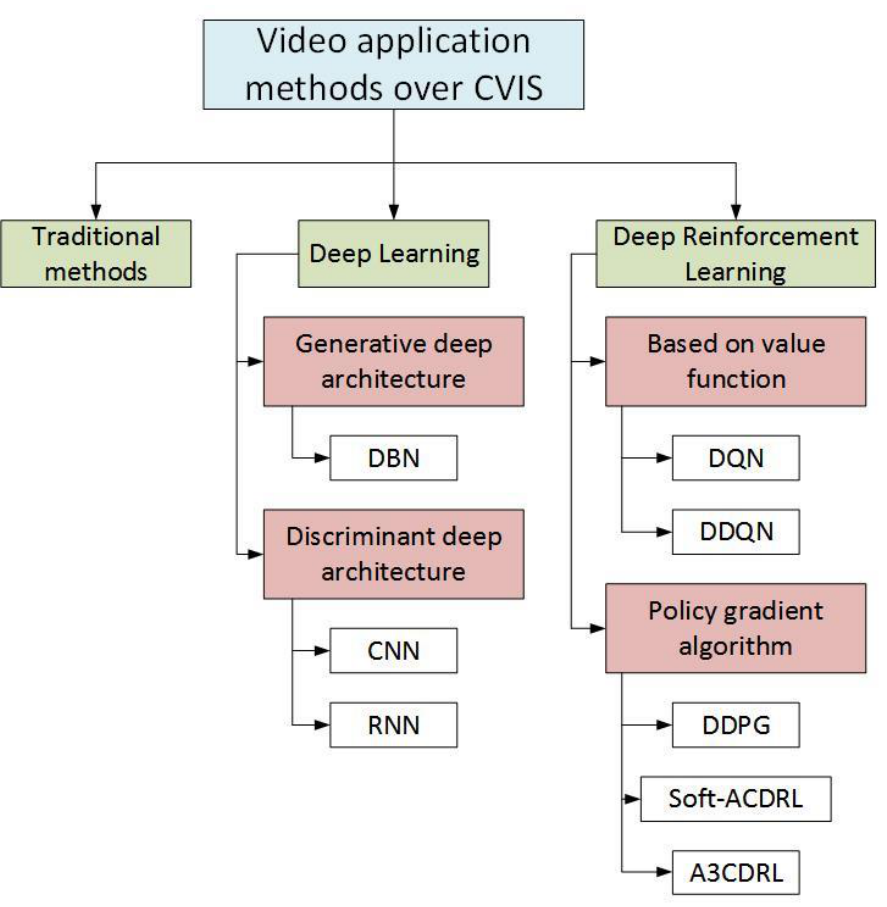
Figure 1. Video application methods over CVIS.